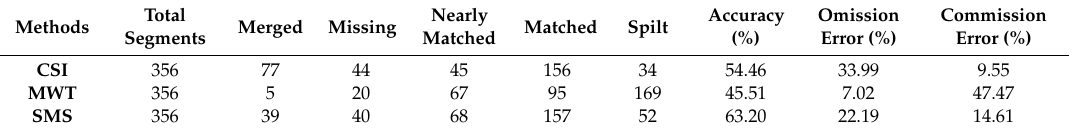
Table 2. The accuracy statistics of the tree crown maps for the deciduous forest plot generated by the Crown Slices from Imagery (CSI) method, the commonly used marker-controlled watershed segmentation (MWT), and the proposed method (SMS), with reference to the same manually delineated tree crown map.